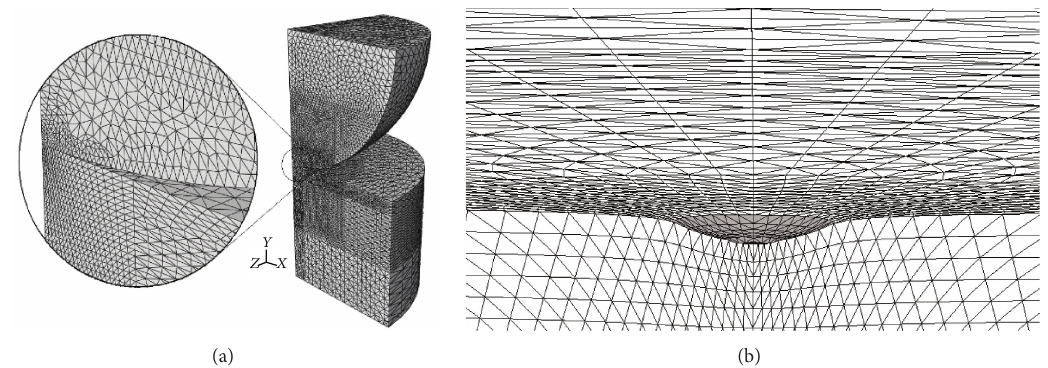
Figure 17: Three-dimensional model of the electric connector (a); sphere indentation (b).